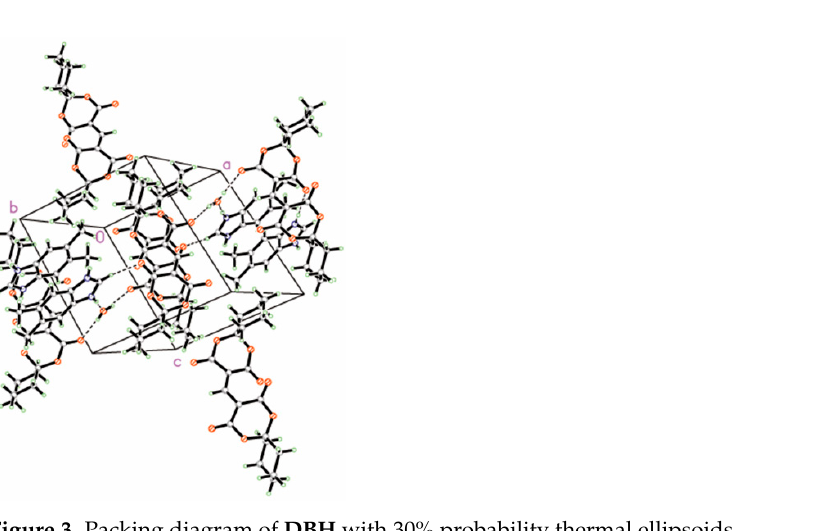
5 of 9 Figure 2. 2D-net structure of DBH. Table 3. N–H···O and O–H···O Molecular Interactions for DBH .